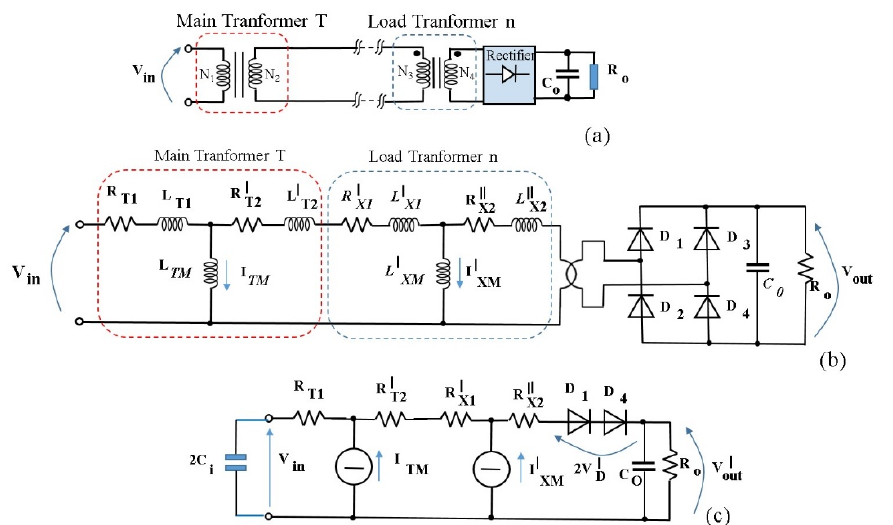
Figure 24. ( a ) Main transformer connected to the load transformer supplying a resistive load. ( b ) Equivalent transformer circuit for both main and load transformers reported in the primary side. The secondary side is connected with a full ‐ bridge rectifier and capacitive filter which supply resistive load. ( c ) Simplified representation of the equivalent circuit of ( b ).